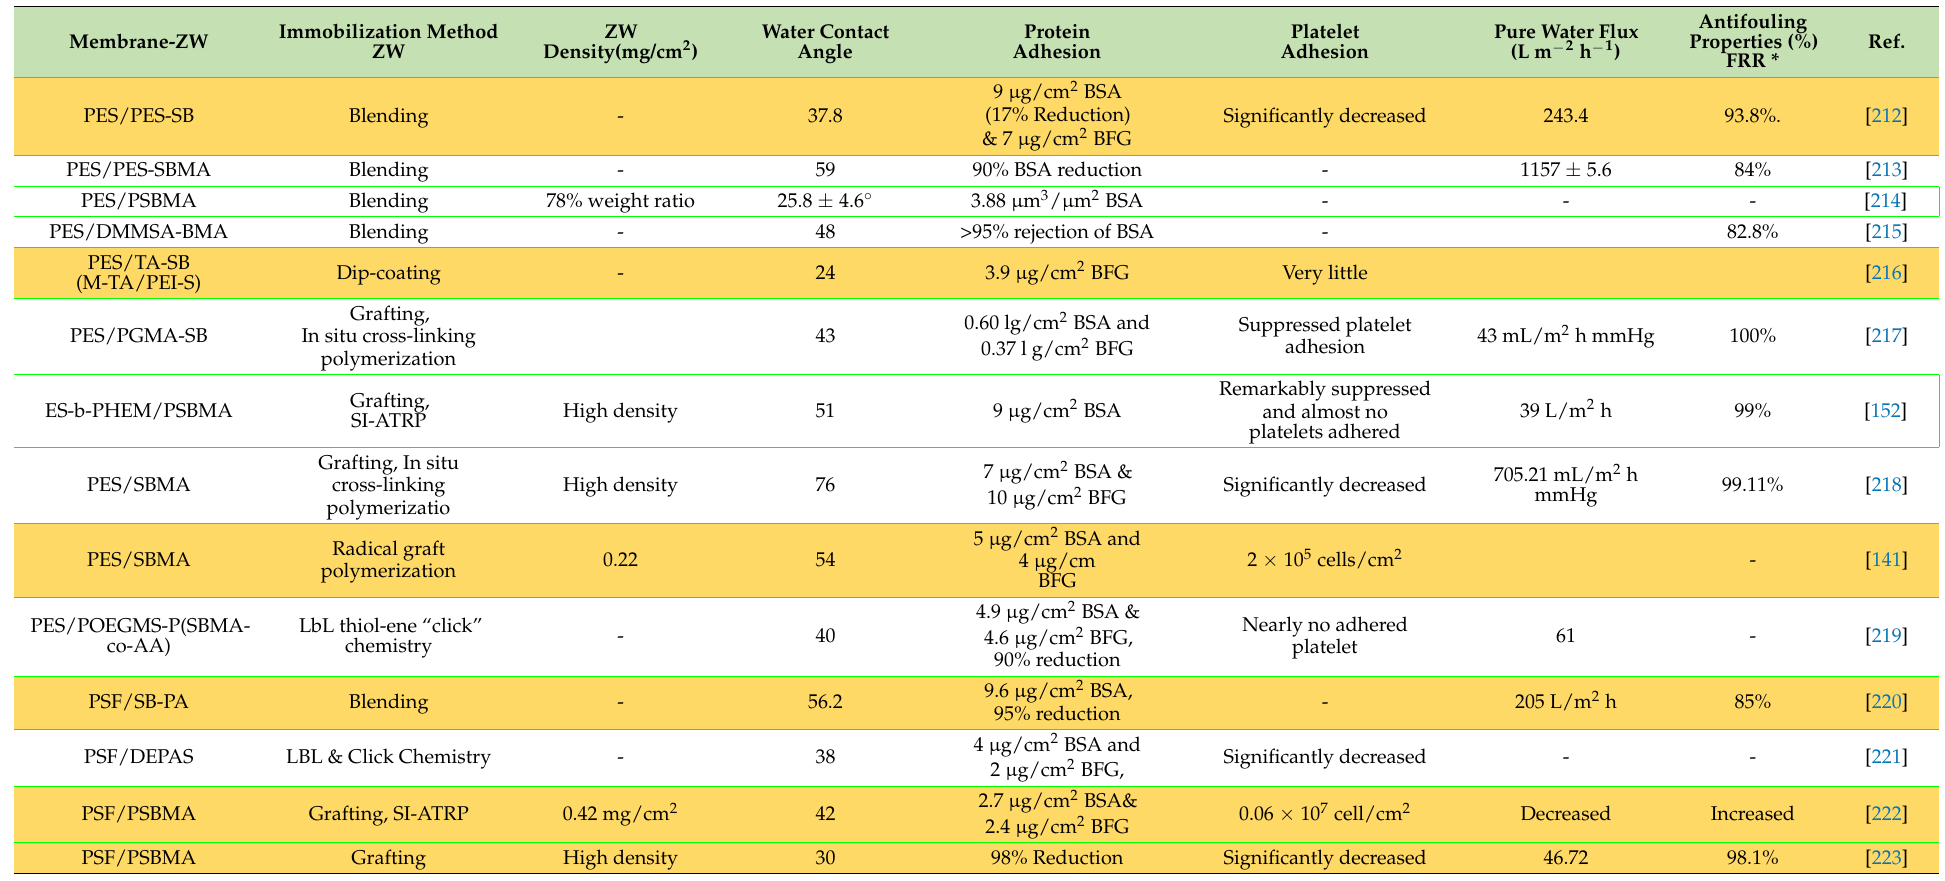
Table 5. Comparison of different modification methods on the hemocompatibility of PES-SB and PSF-SB